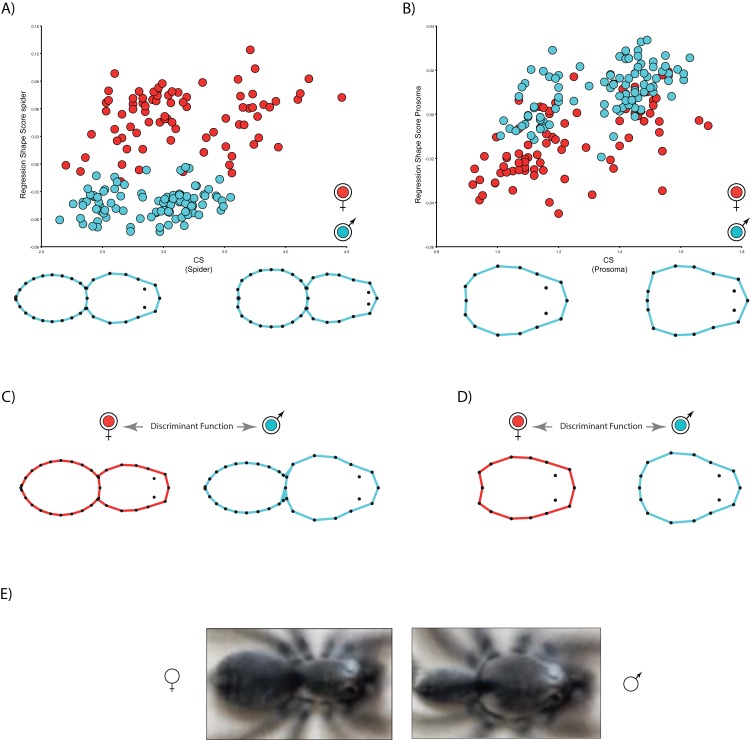
Allometric regressions of spider shape. (A) body and (B) carapace shapes. (C) Histogram with the scores for the leave-one-out cross-validation of Discriminant analysis in body and (D) carapace shapes. (E) Shape differences between females and males shown as image deformations (warps) of the original stock of images computed with the Image Unwarp algorithm using TPSSuper (v.1.15; Rohlf, 2013) (Marugán-Lobón & Buscalioni, 2009; Rohlf, 2002).